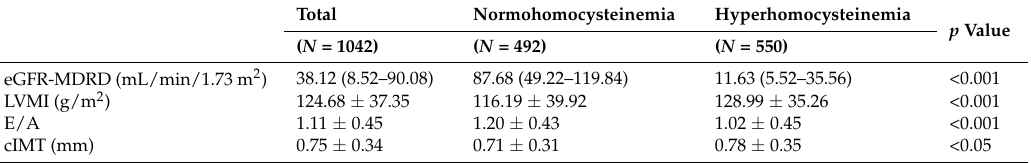
Table 2. Comparison of target organ damage in patients with or without hyperhomocysteinemia. Total